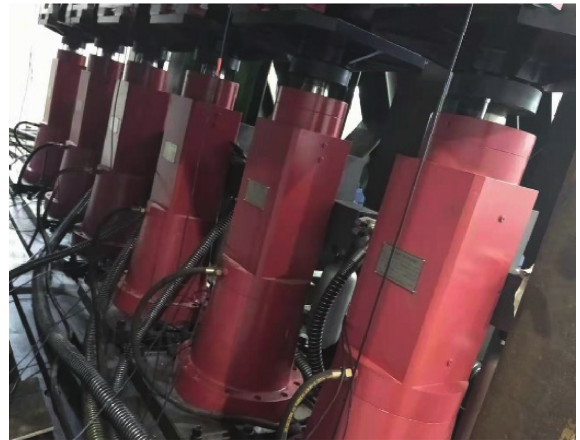
Figure 3: The test bed for the road simulation.